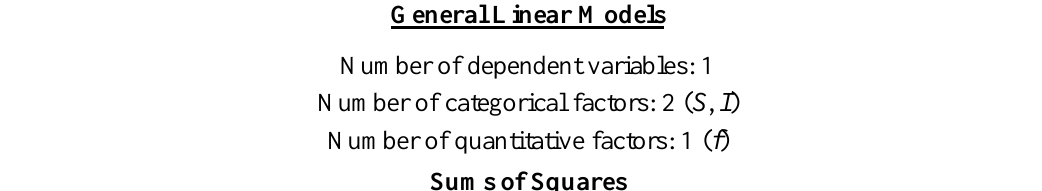
Table 8. Resulting ANOVA table of the temporal trend model without the interaction effects S*f and S*I*f